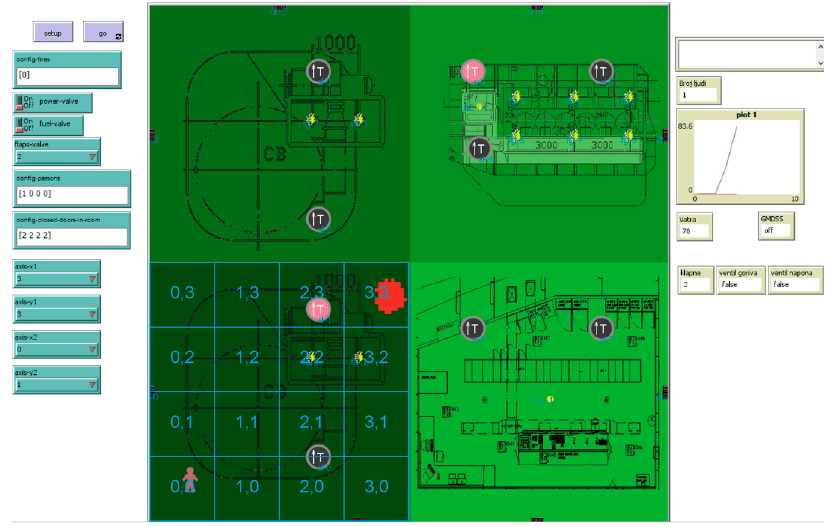
Figure 2. User interface of the developed system.